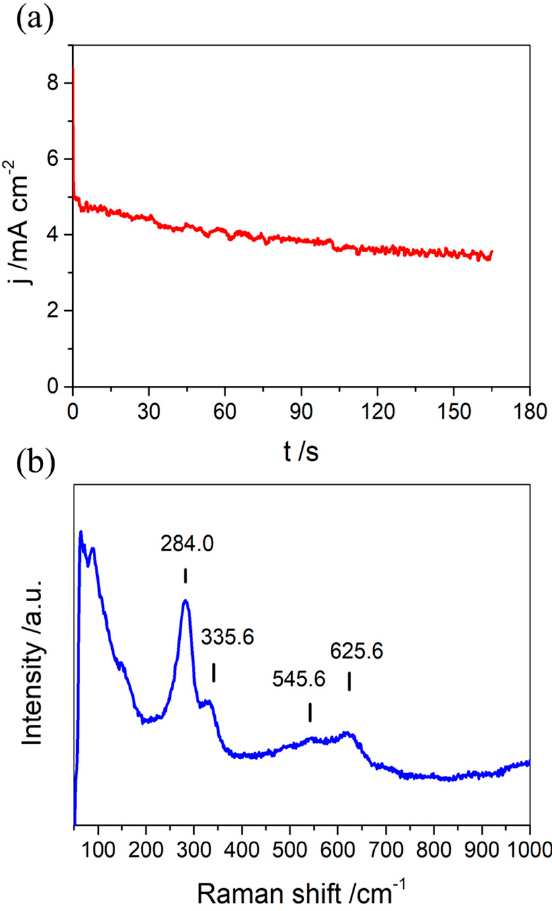
Figure 1. j/t potentiostatic profile ( a ) and Raman spectrum ( b ) for Cu foils anodized at 5 °C applying constant potential of 10 V during 3 min in a 0.1 M KOH + 10% v / v H 2 O + 0.1% w / v NH 4 F electrolyte and dissolved in ethylene glycol.